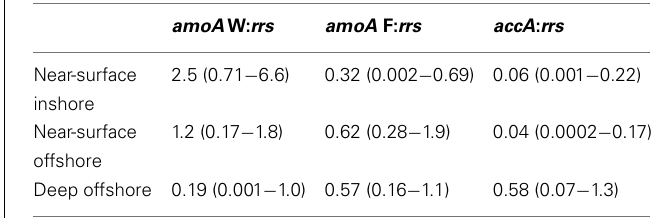
Table 2 | Mean and ranges of the ratios ofThaumarchaeota